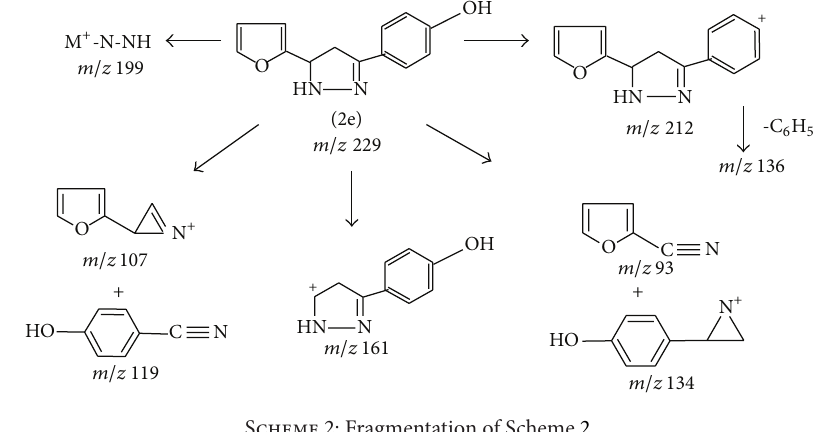
Scheme 2: Fragmentation of Scheme 2.